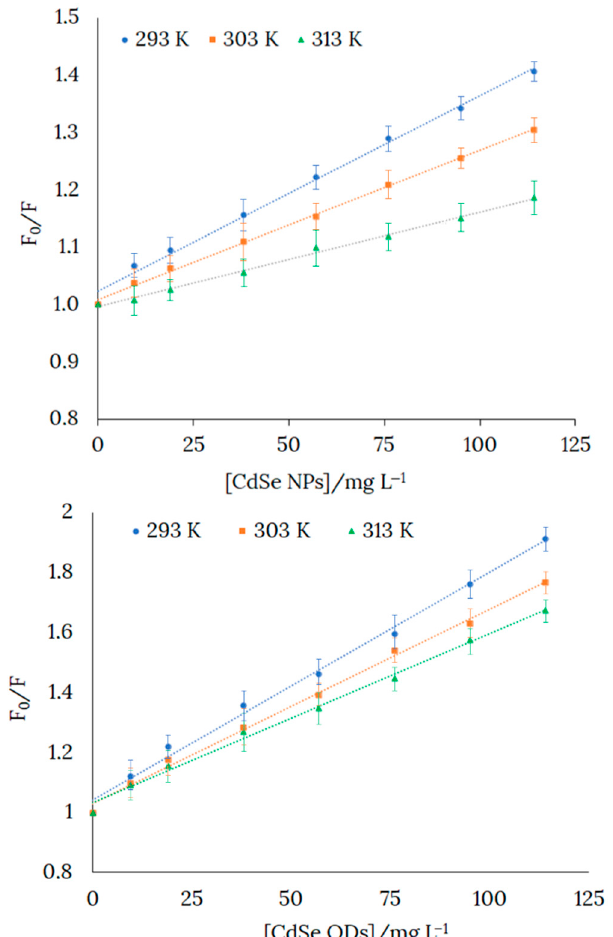
Figure 4. Plots of the intensities of the fluorescence spectra of H 3 L (10 − 4 M) vs. the concentration of the quenchers CdSe NPs ( top ) and CdSe-Cys QDs ( bottom ) in an 80:20 ethanol/water solution. Slopes of the curves at 293, 303, and 313 K are Stern–Volmer constants K SV ( K SV = k q τ , where τ is the lifetime of the fluorophore) at the cited temperatures.